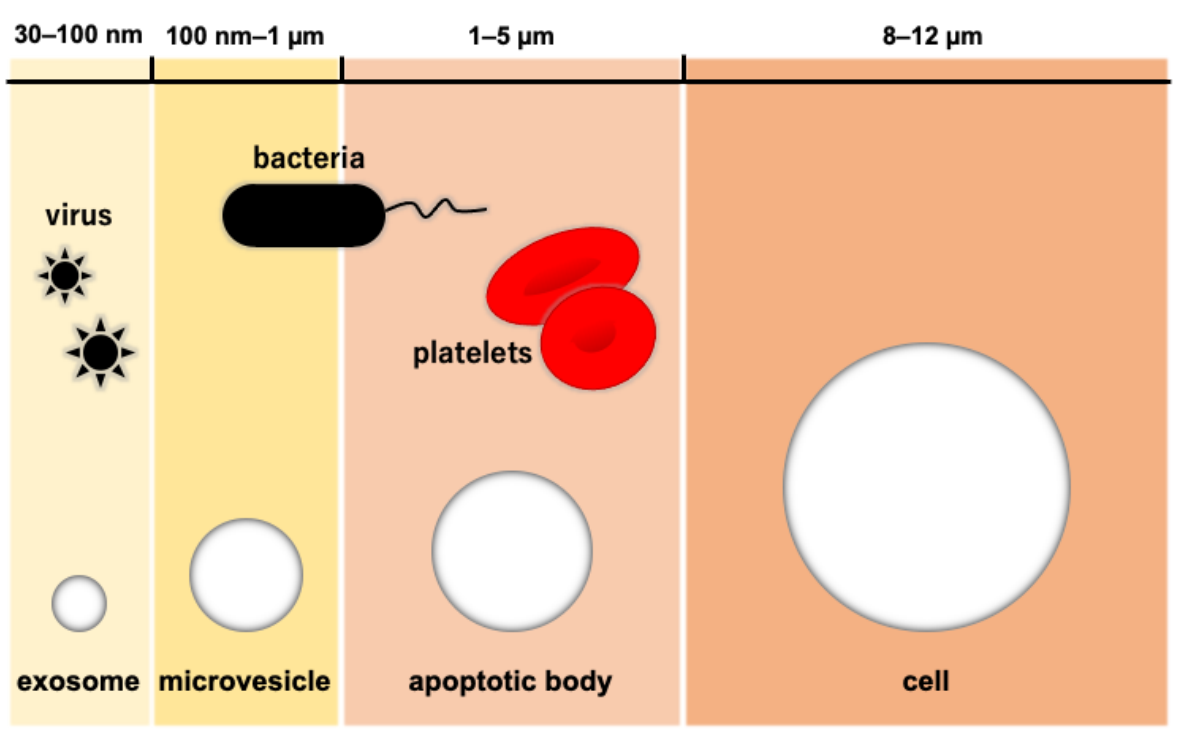
Figure 2. The relative size of extracellular vesicles. Note: Figure 2 was adapted and modified from a previous paper with permission from Elsevier [31].